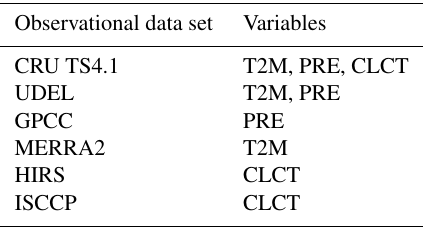
Table 3. List of observational and reanalysis data sets employed for the evaluation of model